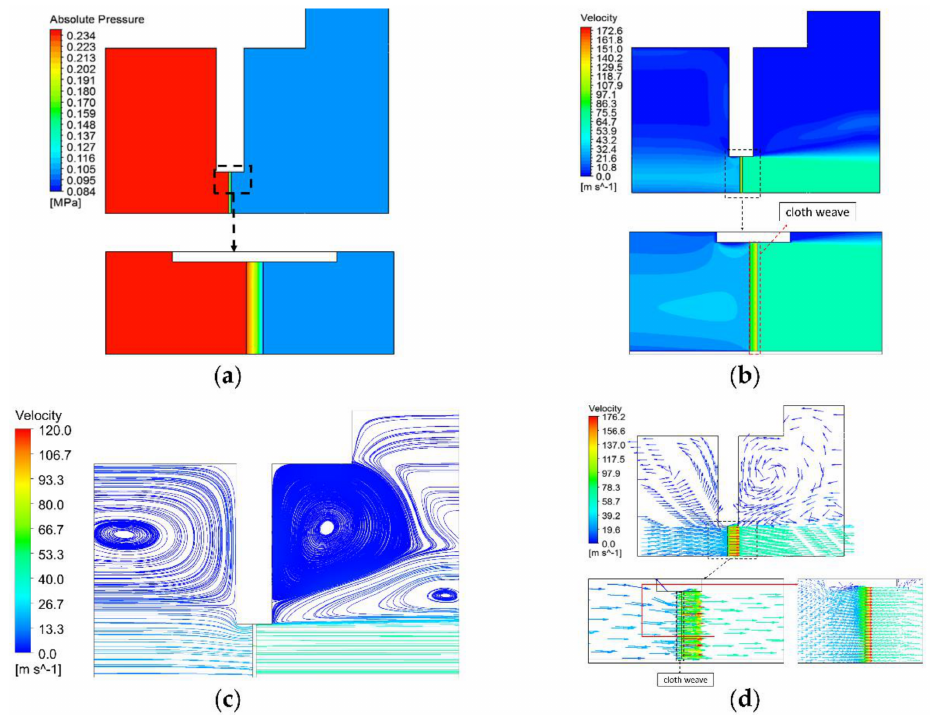
Figure 17. CFD results of cross direction ( C down = 0.0, ∆ P = 137.9 kPad): ( a ) pressure contours, ( b ) velocity magnitude contours, ( c ) velocity streamlines, and ( d ) velocity vectors.